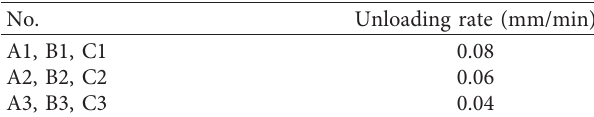
Table 3: Unloading rates of different samples.